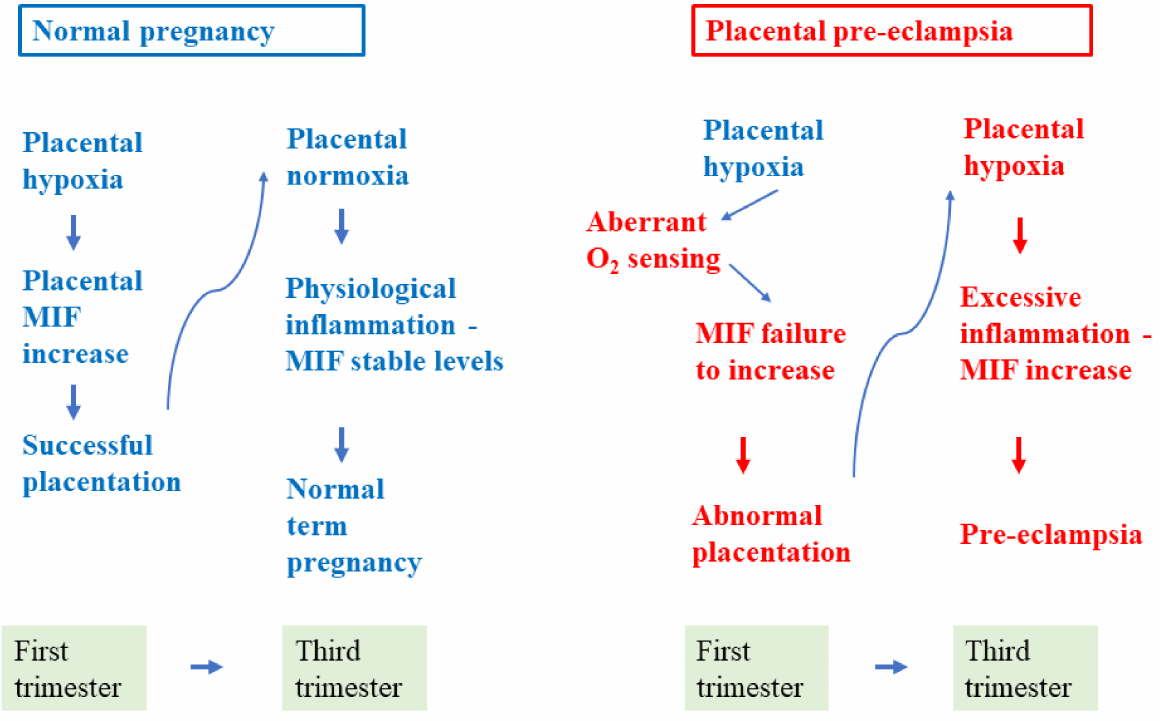
Figure 2. Potential role of MIF in the pathogenesis of placental pre-eclampsia. Low MIF production in early pregnancy would contribute to the abnormal placentation with subsequent placenta hypoxia and increased production of proinflammatory cytokines, placental debris, and oxidative stress leading to